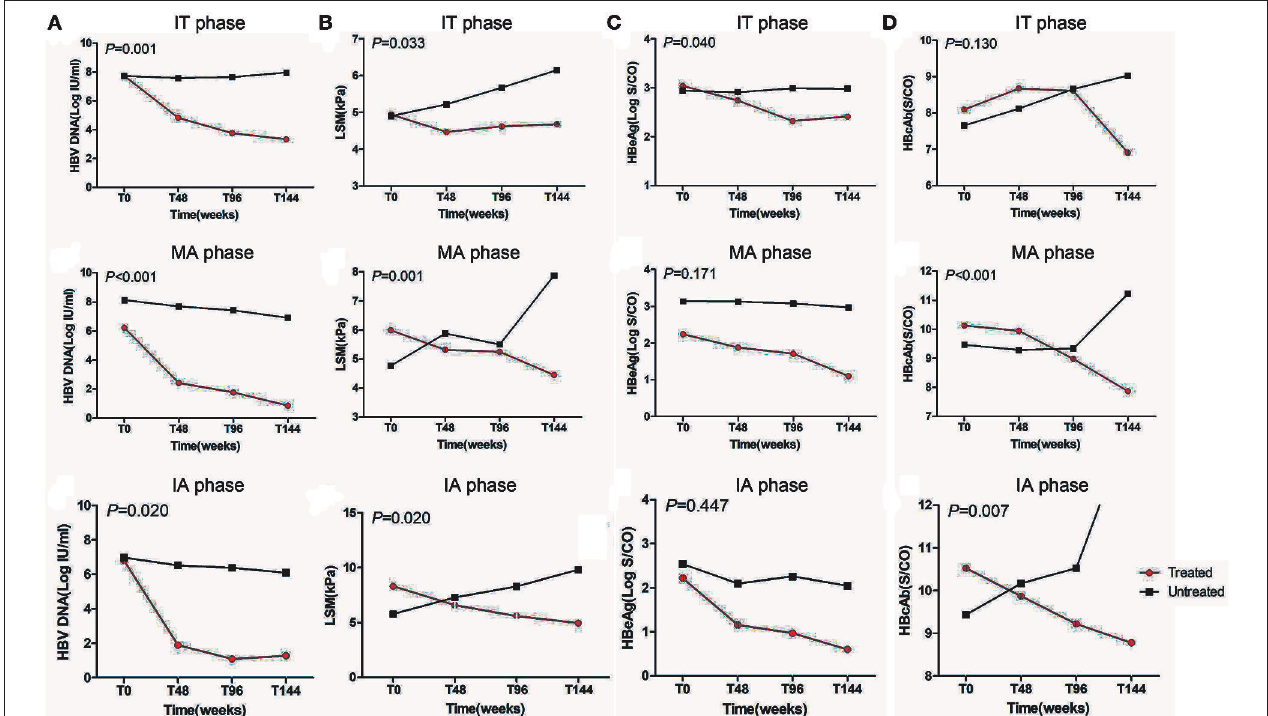
FIGURE 2 | Dynamics of HBV DNA, HBeAg levels, anti-HBc levels, and liver stiffness values from baseline to endpoint. IT, immune tolerant; MA, mildly active; IA, immune active; LSM, liver stiffness measurement.